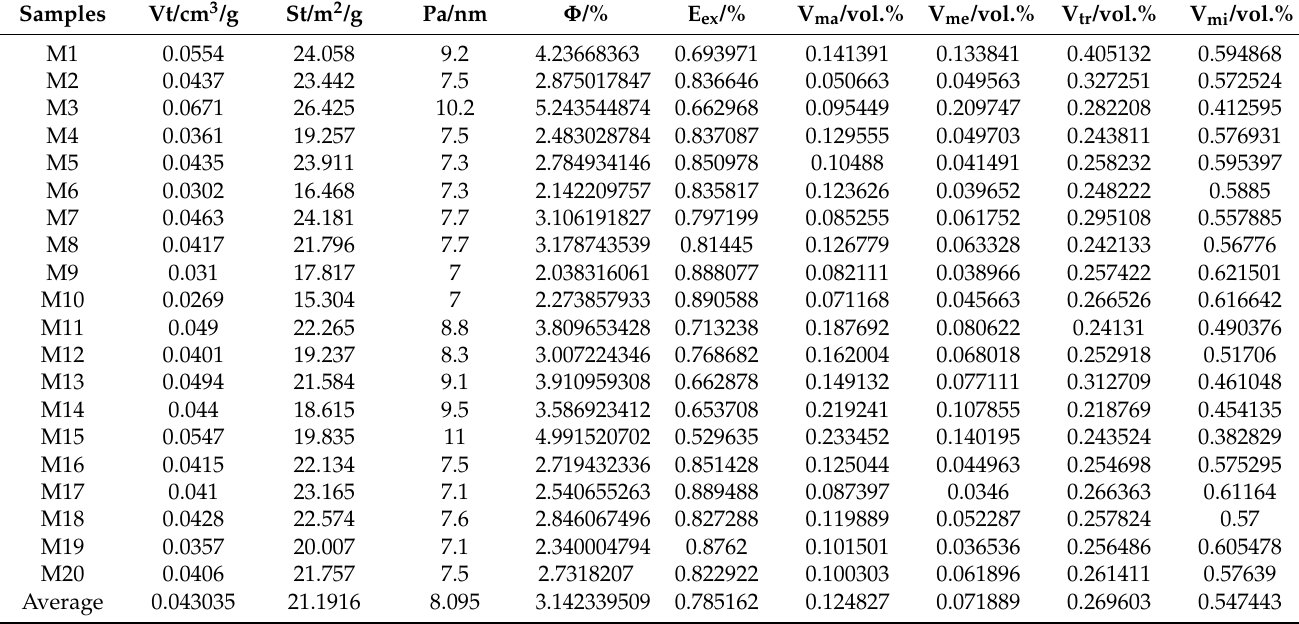
Table 3. Pore structure characteristics of the HPMI analysis of coal